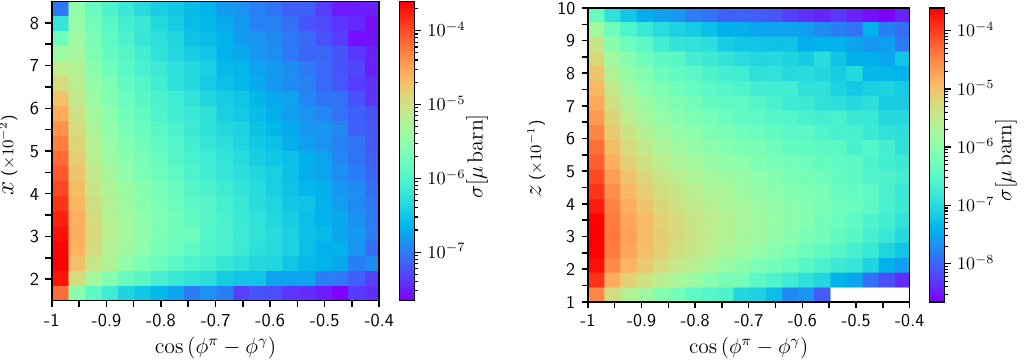
Figure 10: Partonic momentum fractions x cos ( φ π − φ γ ) . The color scale shows the integrated cross-section value per pixel with NLO QCD + LO QED accuracy. We simulated the events using RHIC kinematics (cid:112) = 500 S with CM